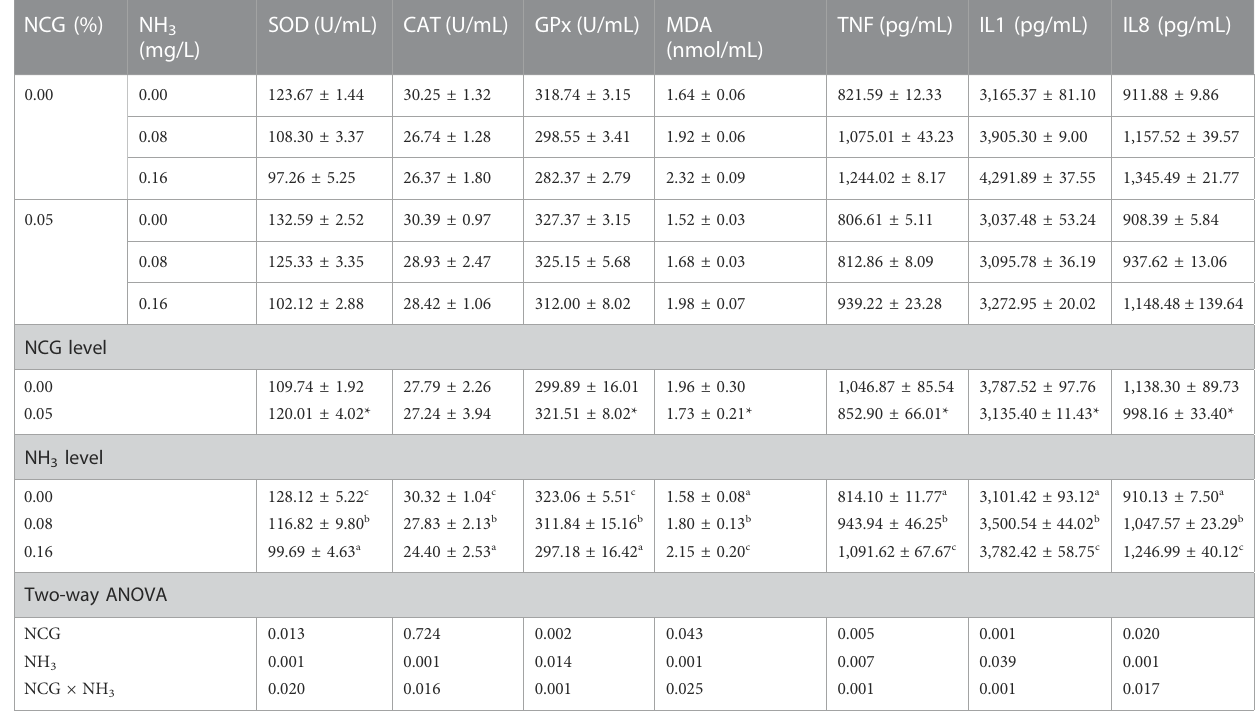
TABLE 7 Effects of dietary N -carbamylglutamate supplementation on serum antioxidant enzyme activity and in fl ammation of yellow cat fi sh exposed to different ammonia levels for 84